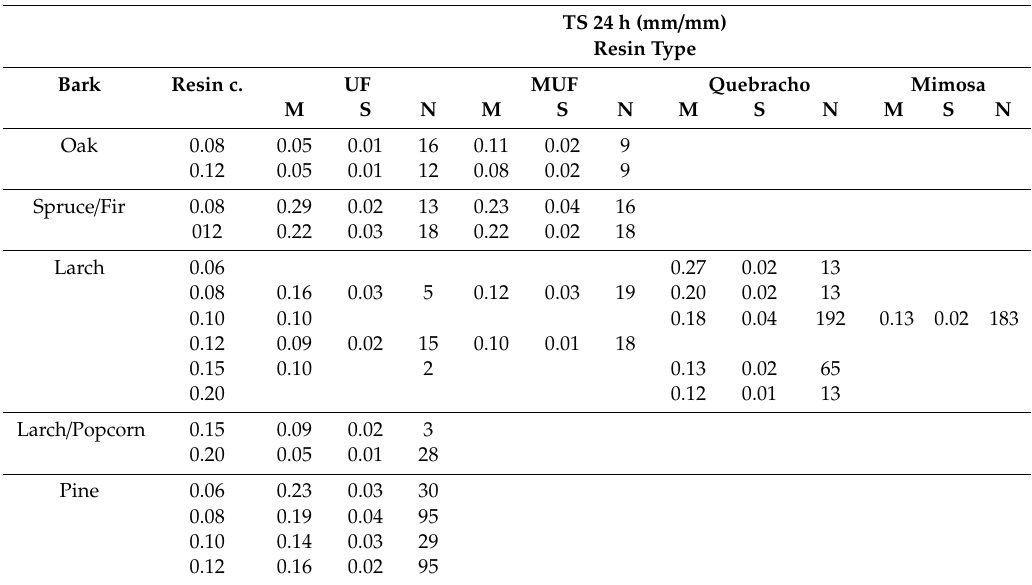
Table 7. TS after 24 h of water